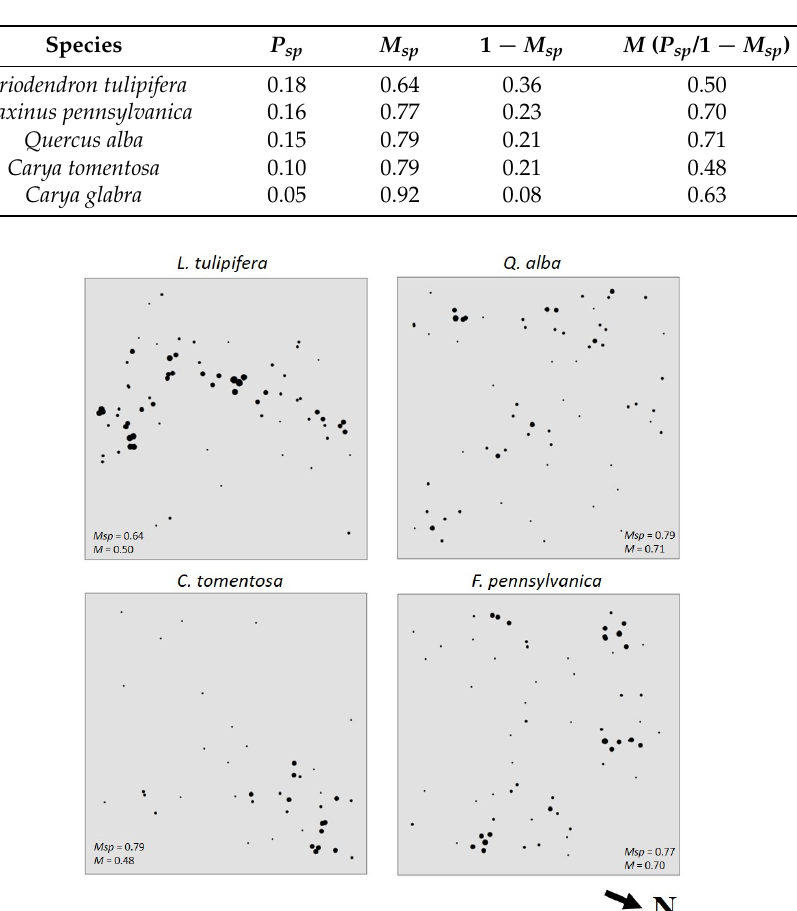
Table 3. Calculation of M for the five most dominant species in a multi-cohort forest on the Oakmulgee Ranger District of the Talladega National Forest, Alabama. Note species proportion ( P sp ) were calculated from trees after implementation of the 5 m buffer zone.